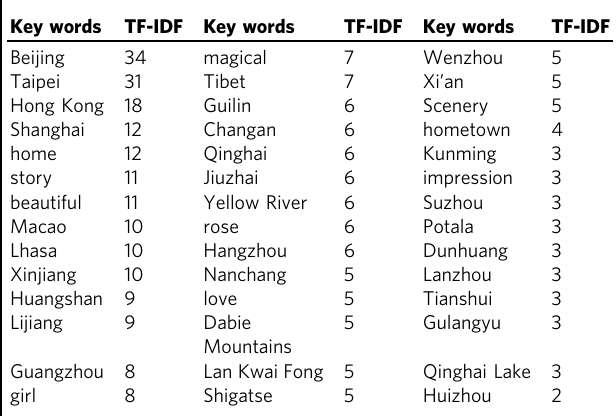
Table 4 Keywords of sense of place: 1980 – 2009. Key words TF-IDF Key words